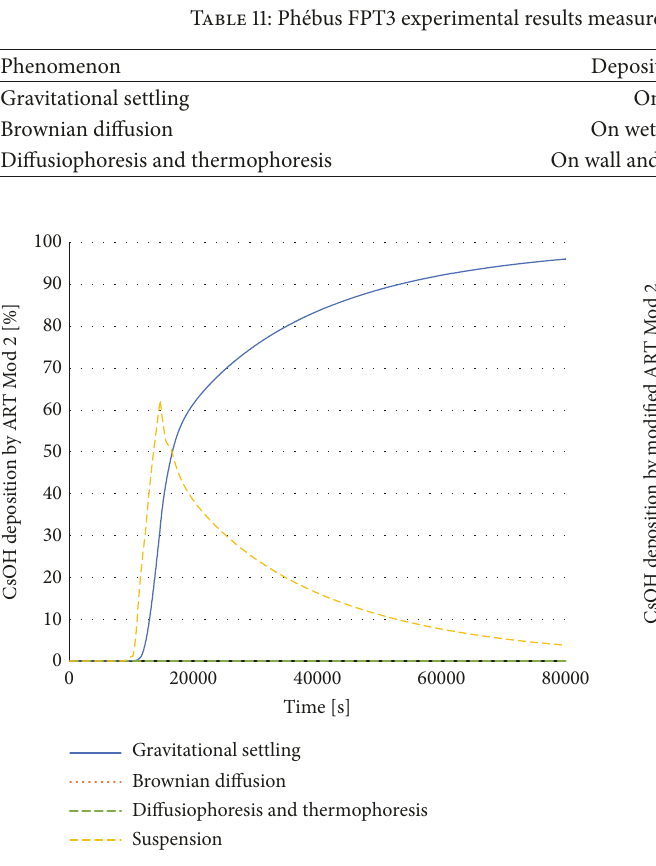
Figure 13: CsOH deposition in containment vessel volume calcu- lated by modified ART Mod